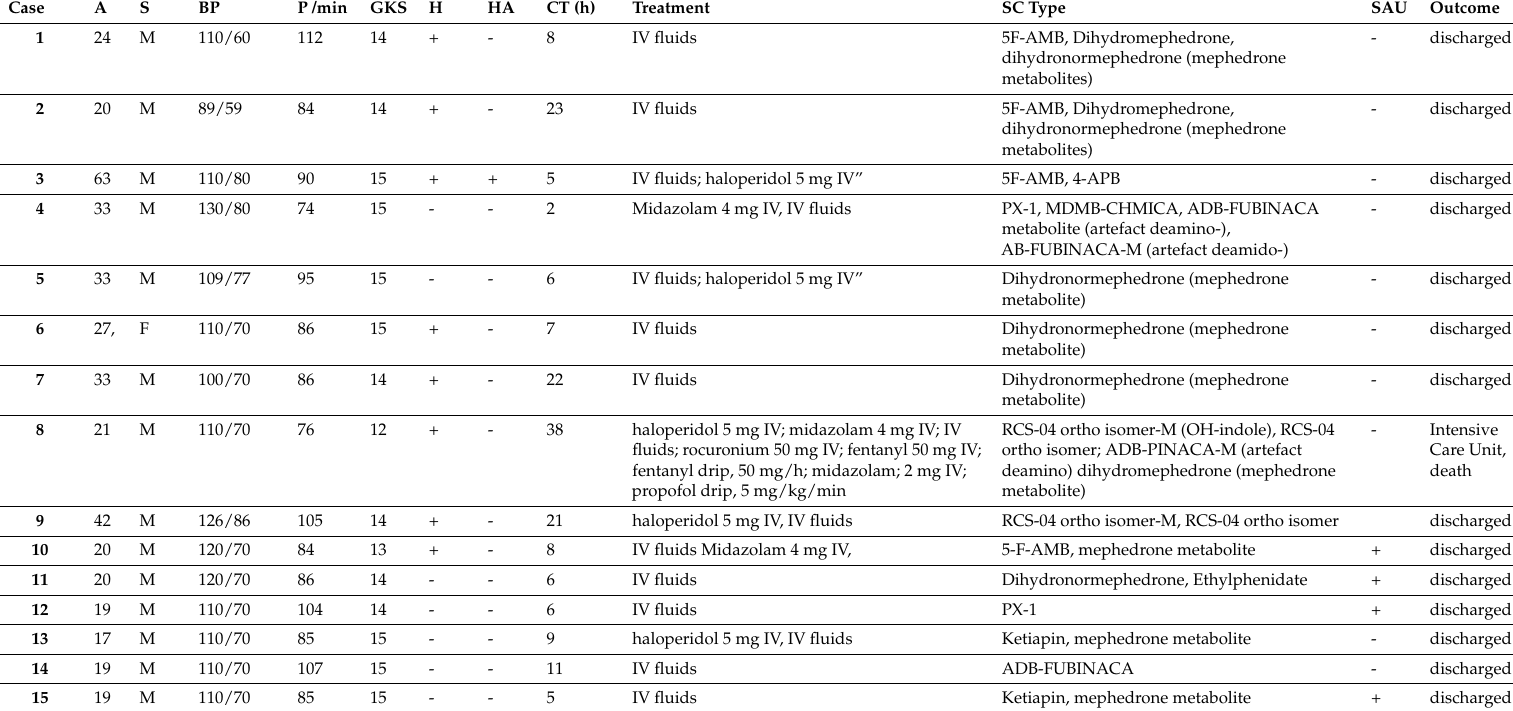
Table 2. Patients’ Characteristics, Treatments and